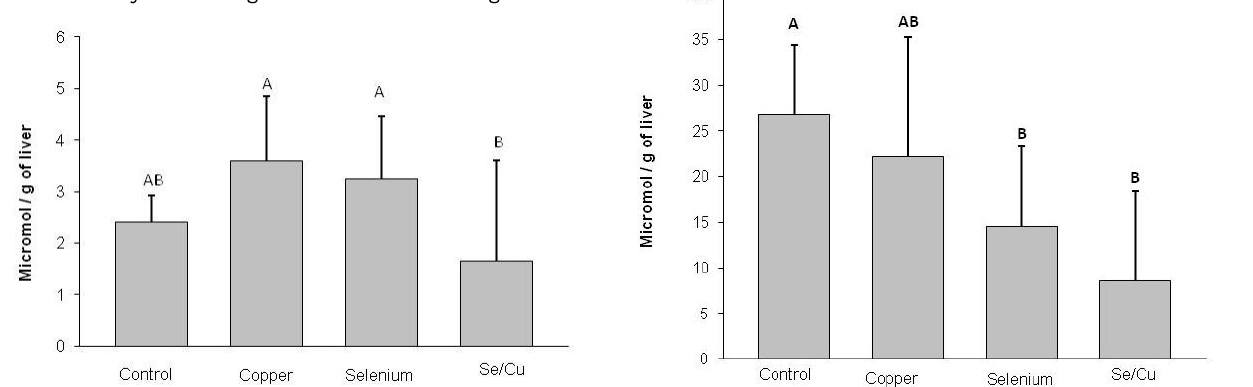
Figure 4. Relation between GSH and GSSG and standard deviations, in  mol per gram of liver, of cattle receiving control diet (without supplementation of selenium and copper), copper (40 mg/kg of DM), selenium (2 mg/kg of DM), or selenium (2 mg/kg of DM)/copper (40 mg/kg of DM).